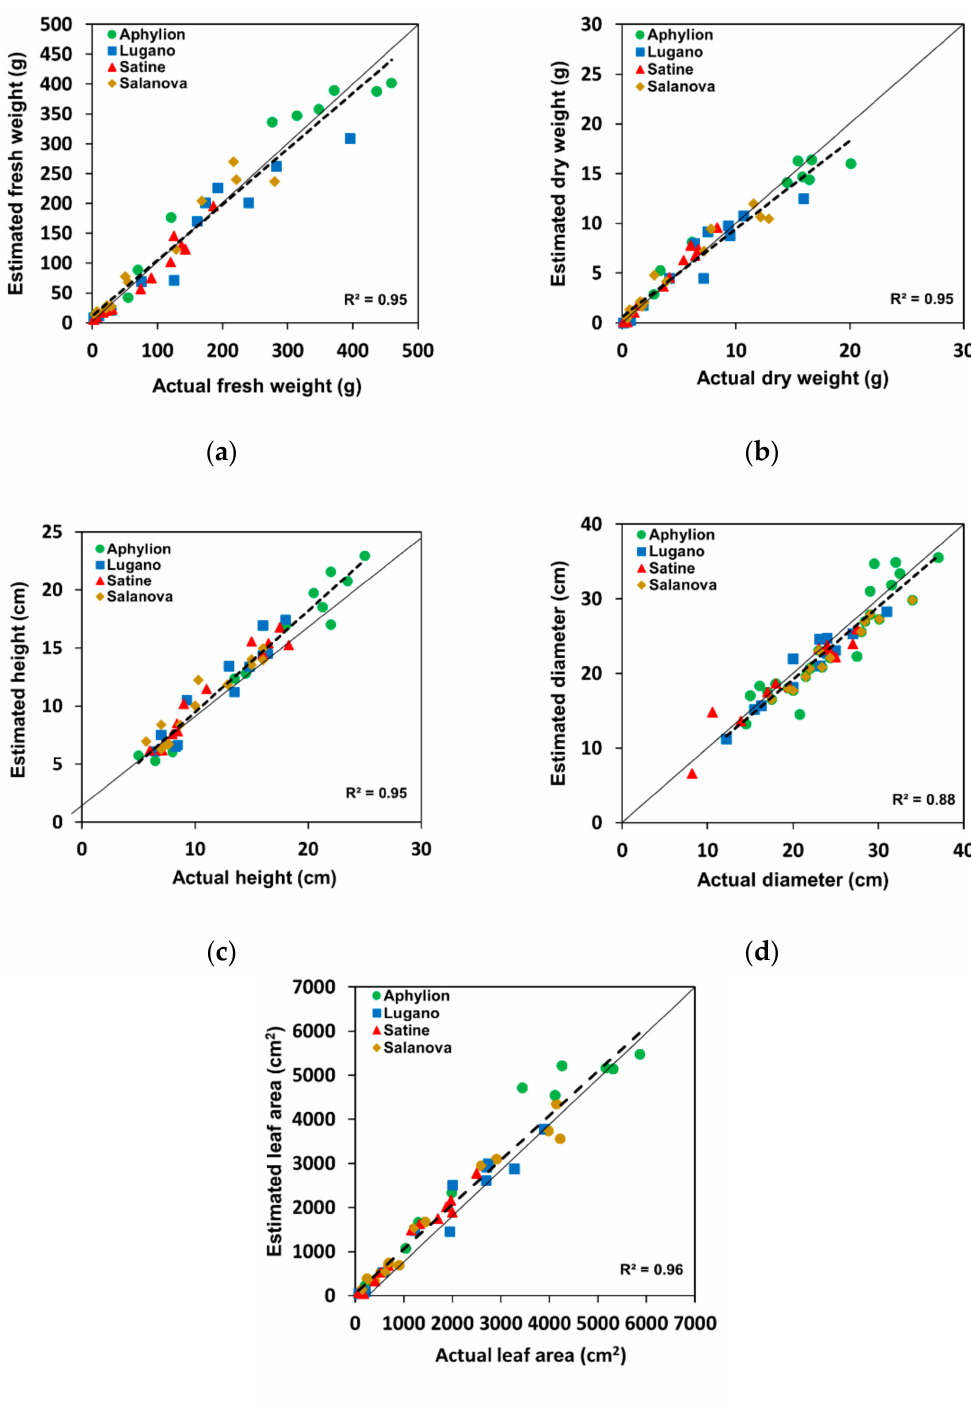
Figure 7. Comparison of growth indicators estimated from the developed model using RGB-D and those measured using the destructive method. The color indices present the values for each lettuce variety: ( a ) fresh weight, ( b ) dry weight, ( c ) height, ( d ) diameter, and ( e ) leaf